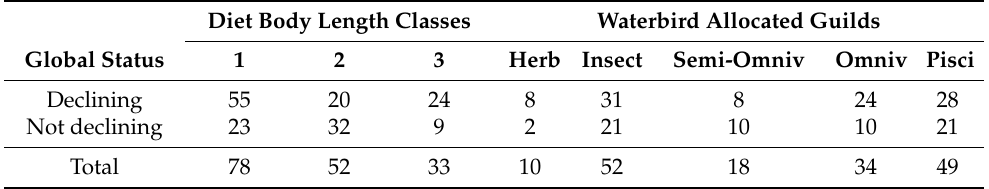
Table 1. Distribution of waterbird population trends across diet body lengths and allocated guilds. Diet Body Length